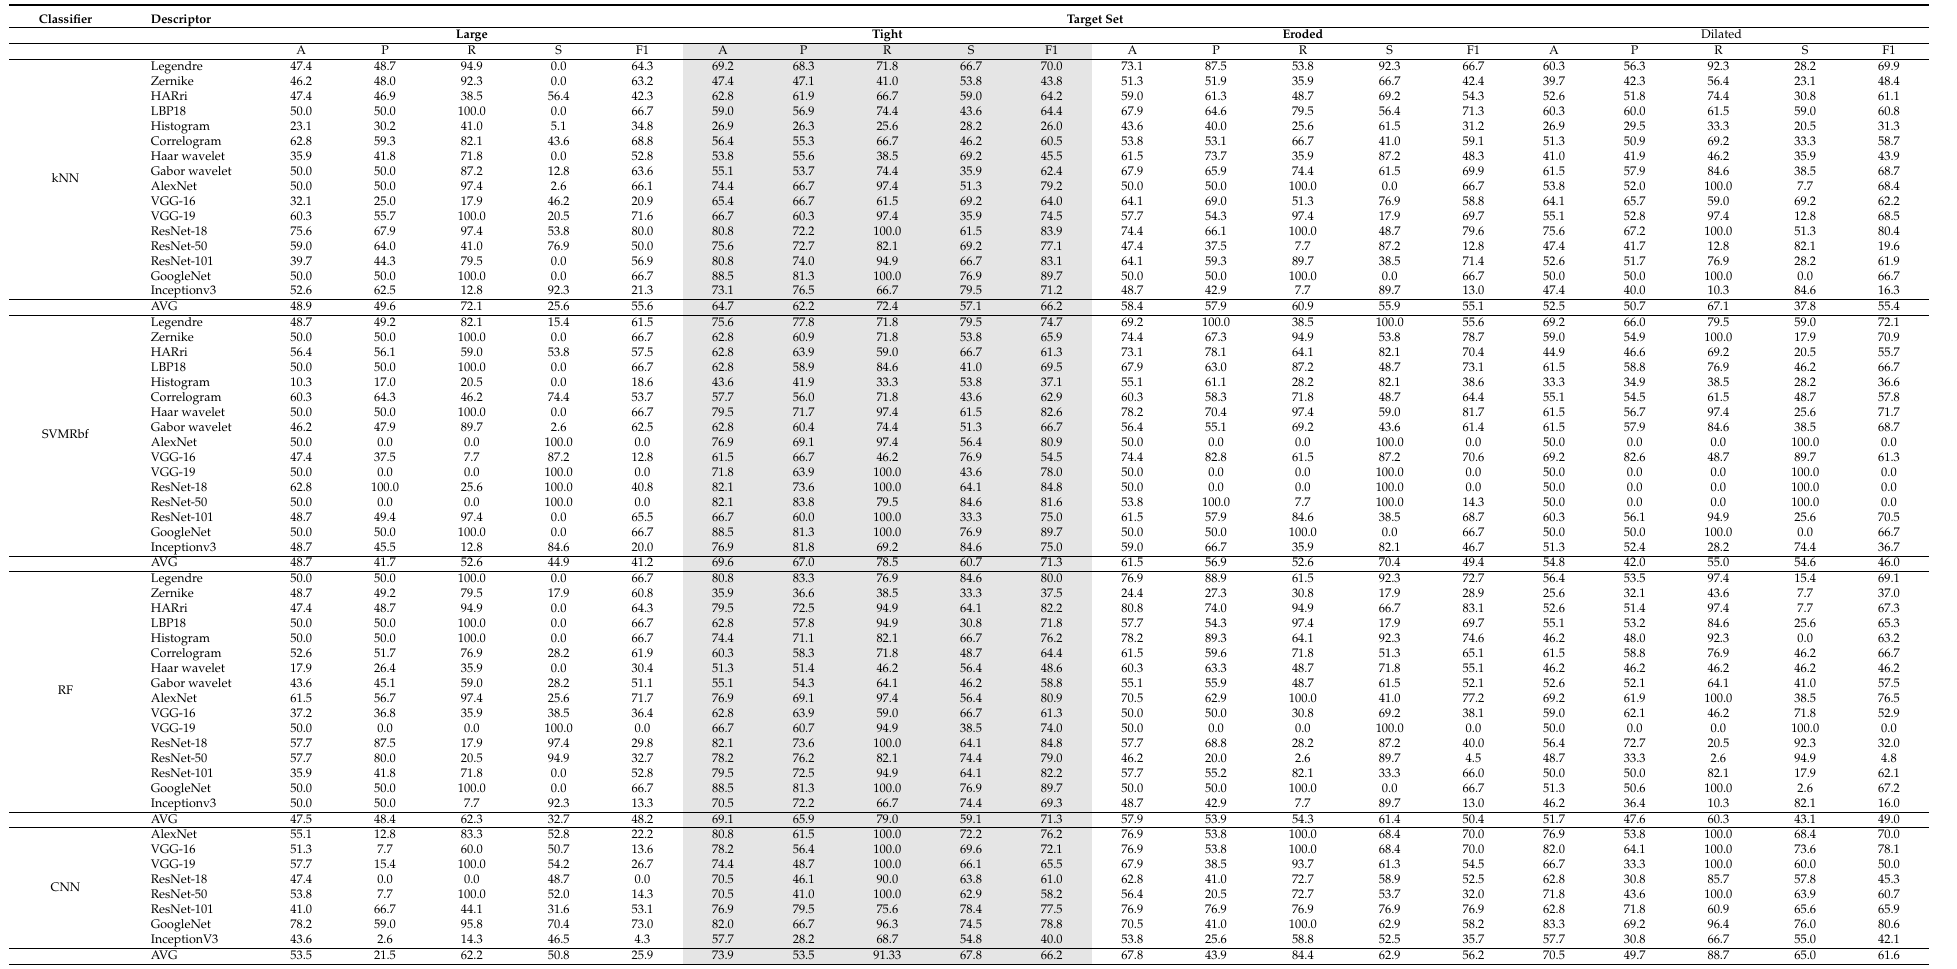
Table 4. ALL-IDB2 performance obtained with source models created exploiting the tight data set version and tested using in turn (from the left) the large, tight, eroded and dilated versions. Same-version performance are highlighted in